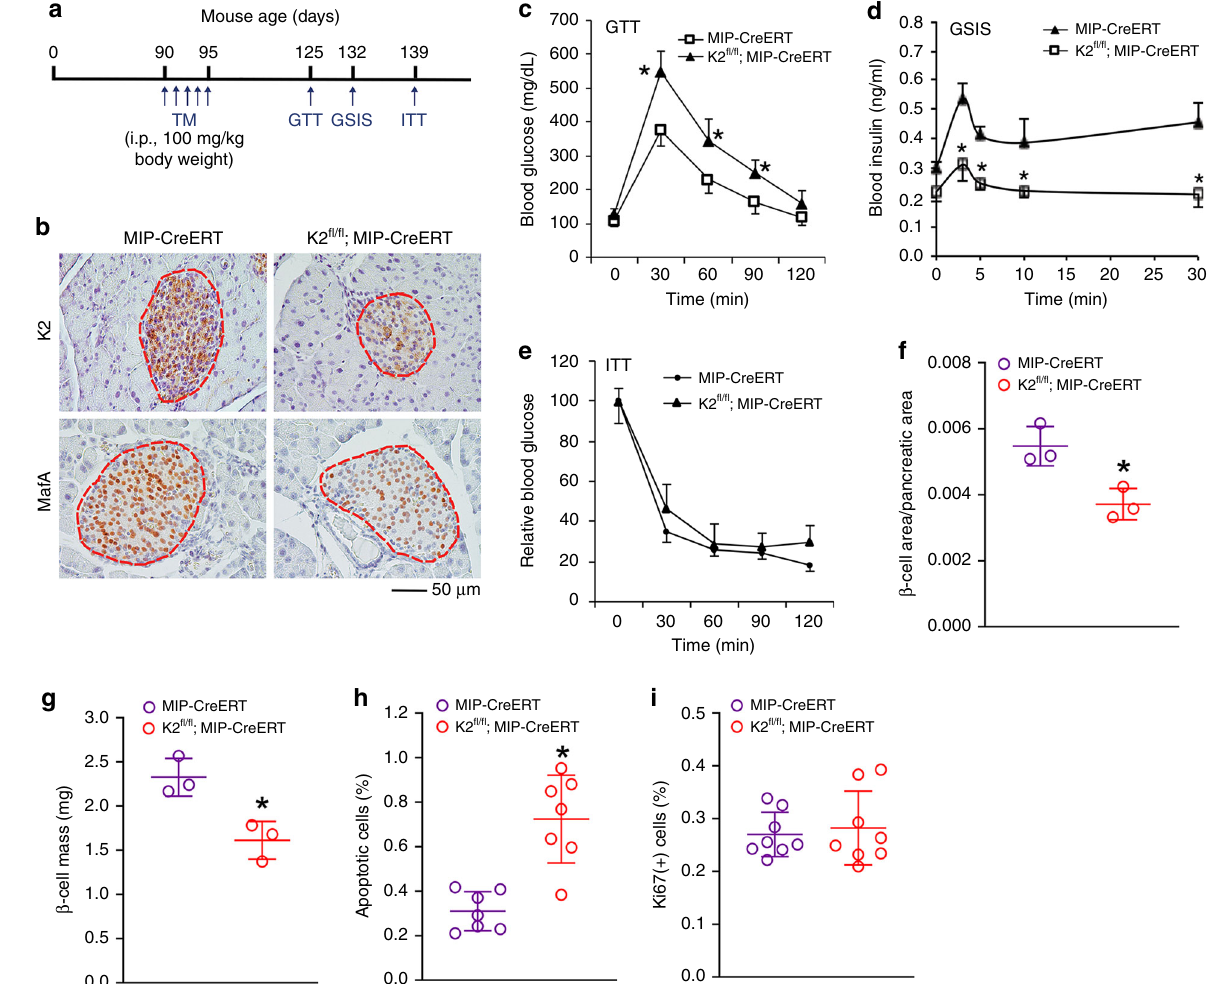
Fig. 6 Inducible deletion of β -cell Kindlin-2 in adult mice leads to diabetes-like phenotypes. a Tamoxifen (TM) injection. b IHC. Three-month-old male K2 f/f ; MIPCreERT and control (MIP-CreERT) mice were treated with TM as described in a . After 30 days, pancreatic sections were stained with antibodies against Kindlin-2 or MafA. Scale bar, 50 μ m. c GTT. Mice were treated with TM as described in a . Thirty days after the TM injection, mice were fasted overnight, and GTT assays were performed. * P < 0.05, versus control, N = 10 for control, N = 7 for K2 f/f ; MIPCreERT , Student ’ s t test. d Glucose stimulated insulin secretion (GSIS). Mice were treated with TM as in a . After 37 days, mice were fasted overnight, and GSIS assays were performed. * P < 0.05, versus control, N = 6 for both genotypes, Student ’ s t test. e Insulin tolerance test (ITT). Mice were treated with TM as in a . After 44 days, mice were fasted for 6 – 7 h, and ITT assays were performed. N = 5 for control, N = 4 for K2 f/f ; MIPCreERT. f , g β -Cell area/pancreatic area ratio and β -cell mass. Mice were treated as in a . After 30 days, pancreatic sections were subjected to IHC staining for insulin, followed by measurements of β -cell area/pancreatic area ratio ( f ) and β -cell mass ( g ). * P < 0.05, versus control, N = 3 per genotype. h Cell apoptosis. Mice were treated with TM as in a . After 30 days, pancreatic sections were subjected to insulin and TUNEL staining. Around 300 – 500 β -cells (insulin-positive cells) per mouse were counted. N = 7 mice per group. * P < 0.05, versus control, Student ’ s t test. i Cell proliferation. Mice were treated with TM as in a . After 30 days, pancreatic sections were double stained with antibodies against insulin and Ki67. Ki67-positive cells in islets were normalized to total insulin-positive cells in the same area ( i ). Around 300 – 500 β